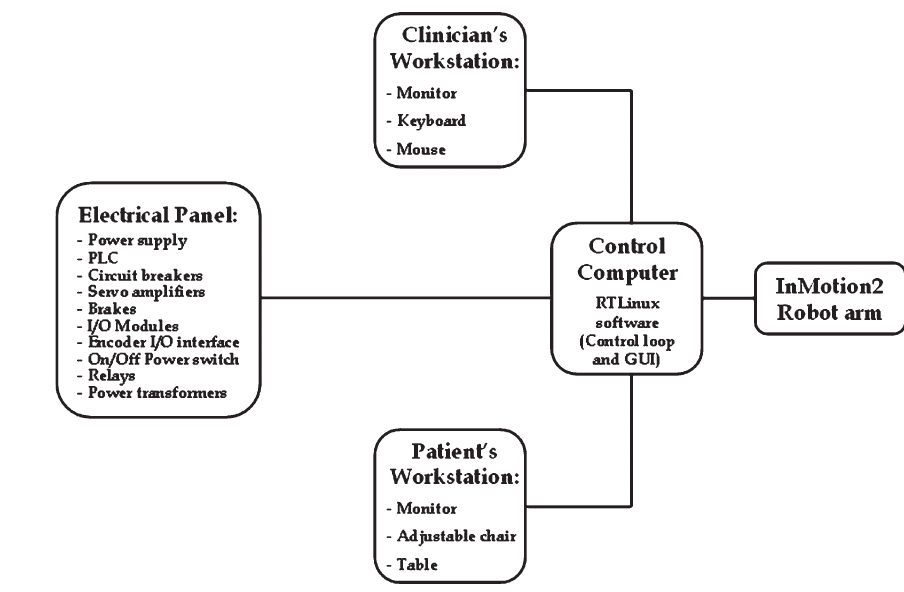
Fig. 2. Block diagram of the experimental setup.